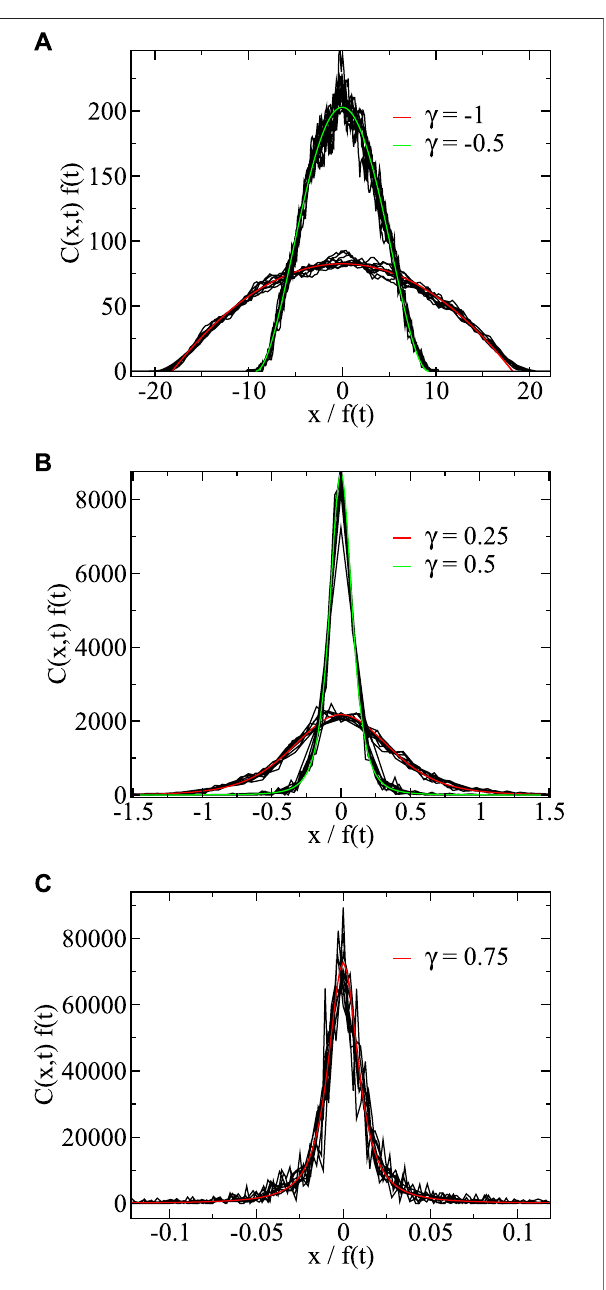
FIGURE 3 | Scaled concentration as a function of scaled position for negative (A) and positive (B,C) γ -values. For the negative γ -values dt (cid:2) 10 − 5 , and a running average over a window of 10 data points was applied. For the positive γ -values dt (cid:2) 10 − 4 , no running average wasapplied. Inall cases D 0 (cid:2) 1 (in units of the lattice constant 2 /timestep) and N p (cid:2) 2,000. The red and green curves show the analytic solutions given in Eq. 30 and Eq. 32 .